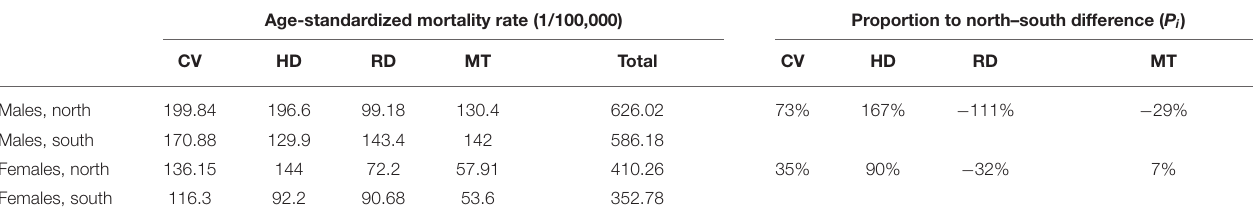
TABLE 2 | Age-standardized mortality rates with leading causes of death and their proportion on north–south differences in all-cause mortality rate in 2013. Age-standardized mortality rate